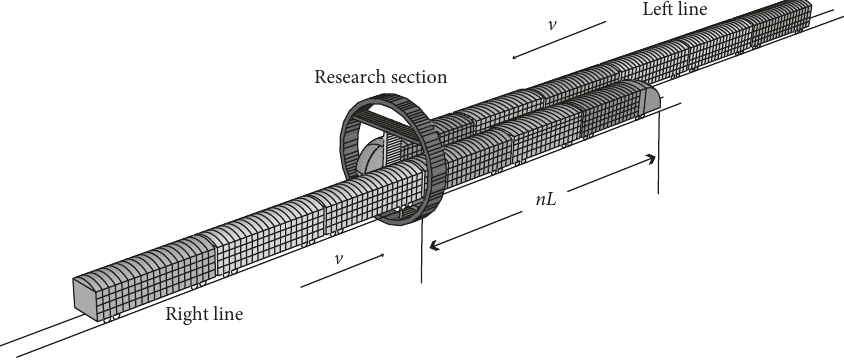
Figure 3: A typical scenario of train meeting in a single-hole double-track